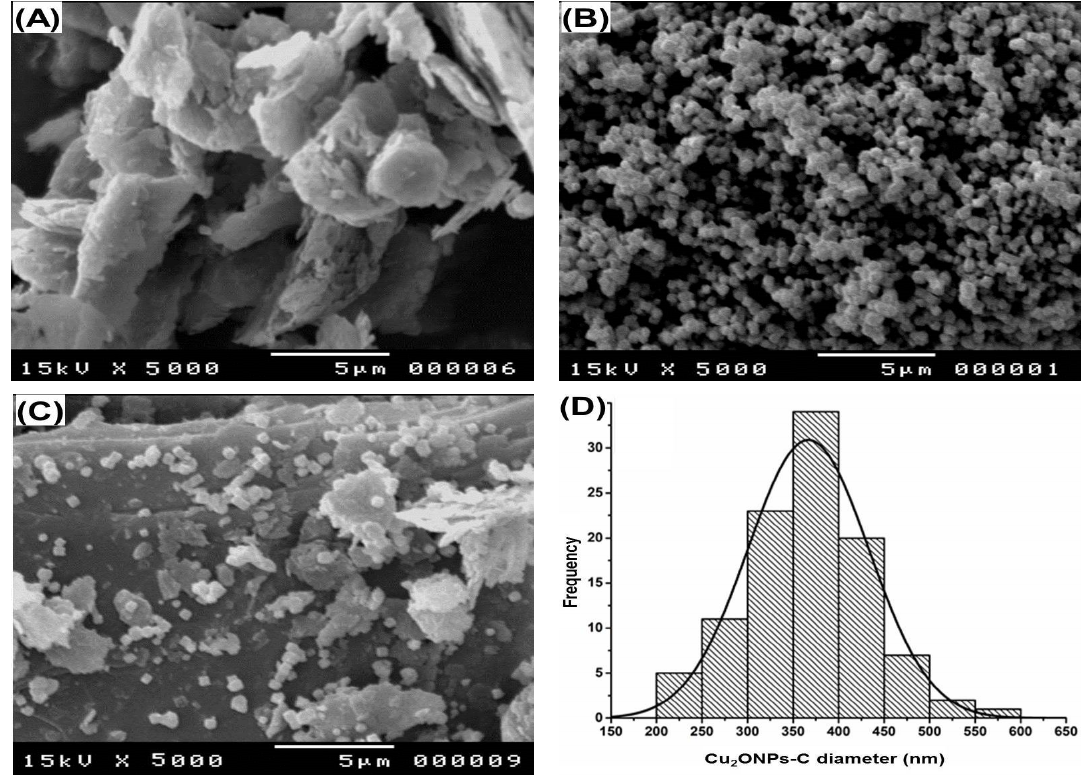
Figure 3. SEM images of: ( A ) bare graphite grains, ( B ) pure synthesized Cu 2 ONPs–C, ( C ) Cu 2 ONPs–C@G and ( D ) diameter distribution of Cu 2 ONPsC.